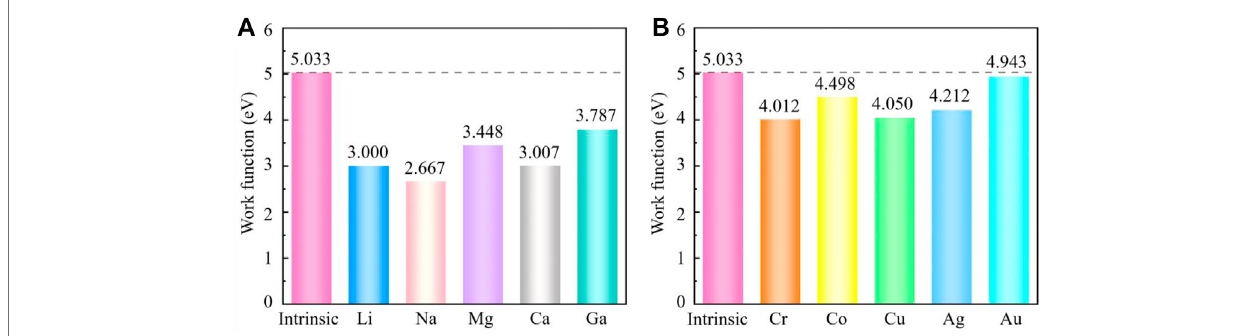
FIGURE 3 | The work functions of the intrinsic g-ZnO and (A) M or (B) TM adsorbed g-ZnO systems.